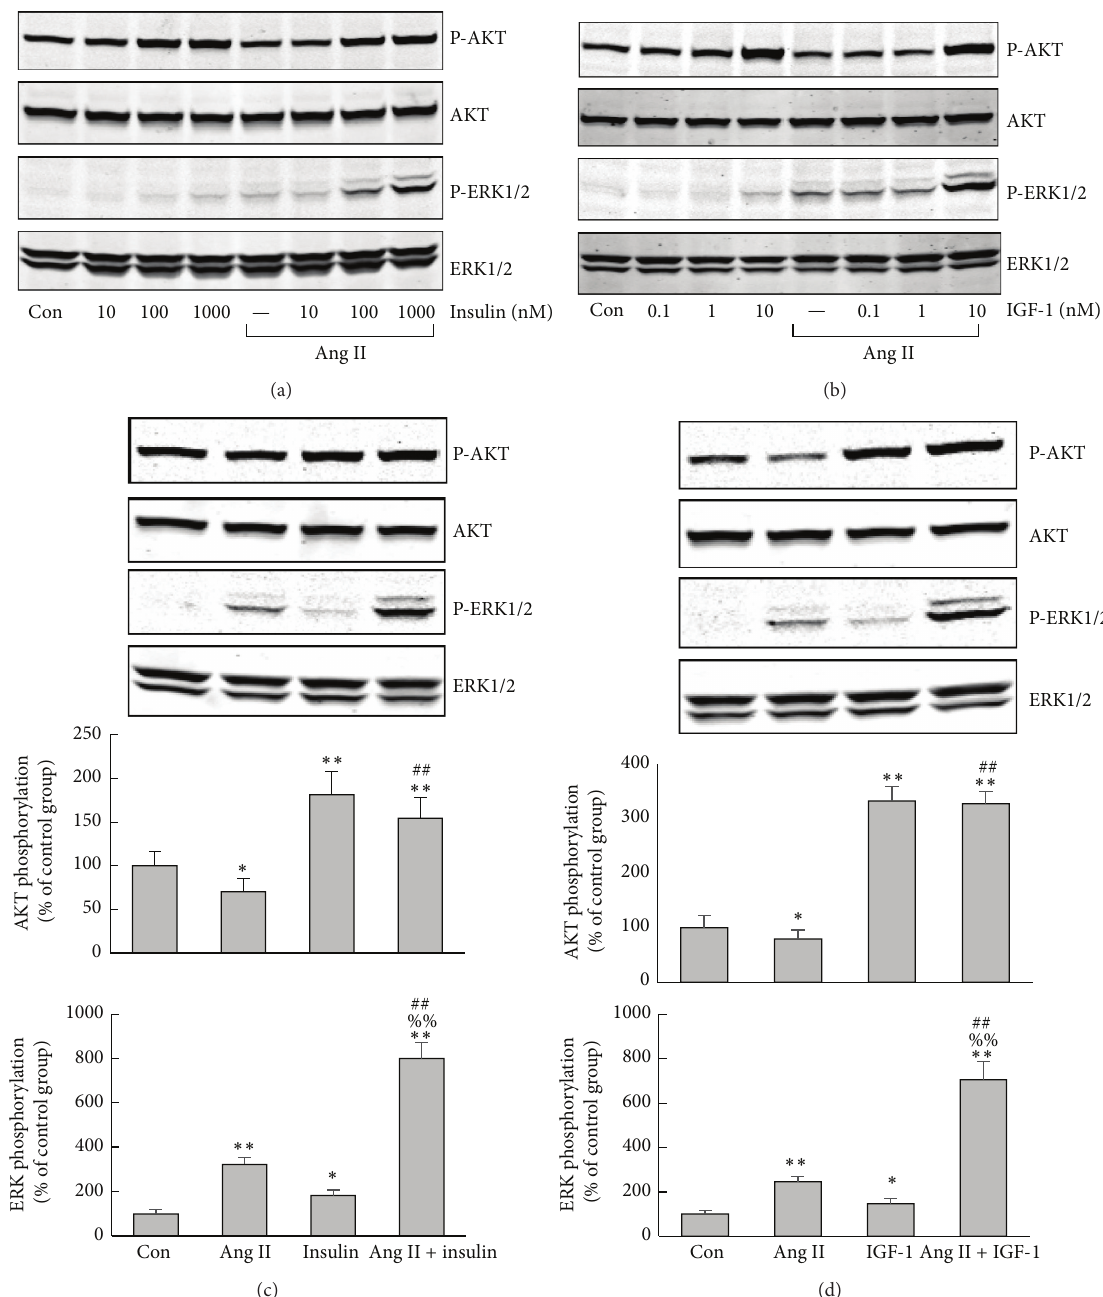
Figure 2: Effect of Ang II and insulin/IGF-1, alone or combined, on phosphorylation of ERK1/2 and AKT in H295R cells. (a-b) Serum-starved H295R cells were treated with increasing concentrations of insulin/IGF-1 for 5 min with or without 30-minute preincubation with 100nM Ang II. (a) Insulin (10, 100, and 1000 nM); (b) IGF-1 (0.1, 1, 10nM). (c-d) Serum-starved H295R cells were treated with insulin (100nM)/IGF- 1 (10nM) for 5 min with or without 30-minute preincubation with 100nM Ang II. The histogram shows the densitometric result of the phosphorylation of three independent experiments. ERK1/2 and AKT phosphorylation in control group were taken as 100%. ∗ 𝑃 < 0.05 versus control, ∗∗ 𝑃 < 0.01 versus control, ## 𝑃 < 0.01 versus Ang II alone, and %% 𝑃 < 0.01 versus insulin/IGF-1